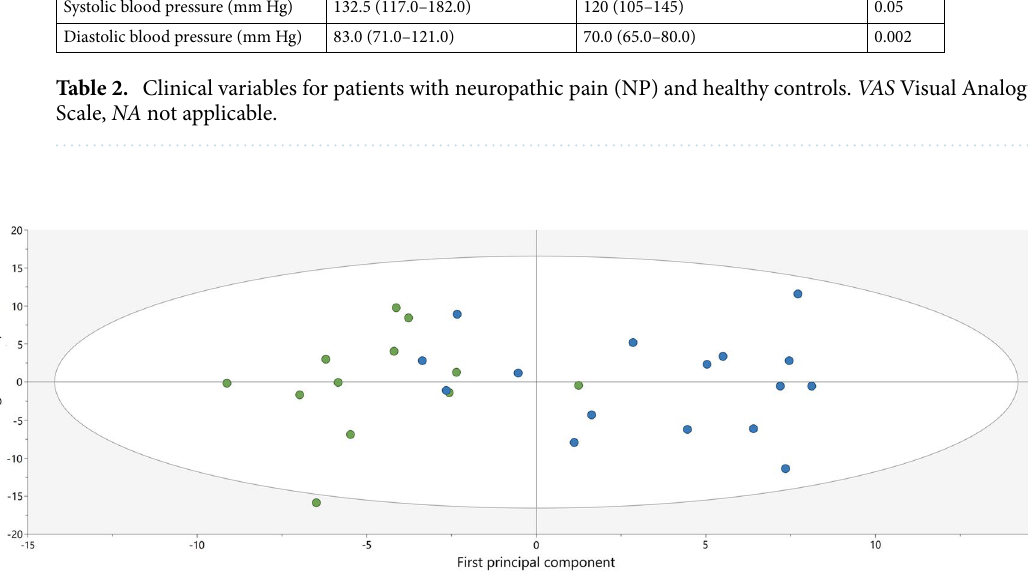
Figure 1. A score scatter plot depicting the subjects in each group (control group: n = 12, green dots; NP group: n = 16, blue dots) according to the Orthogonal Partial least square discriminant analysis (OPLS-DA) model based on metabolite concentrations in plasma. The horizontal axis shows the group separation while the vertical axis shows the within group